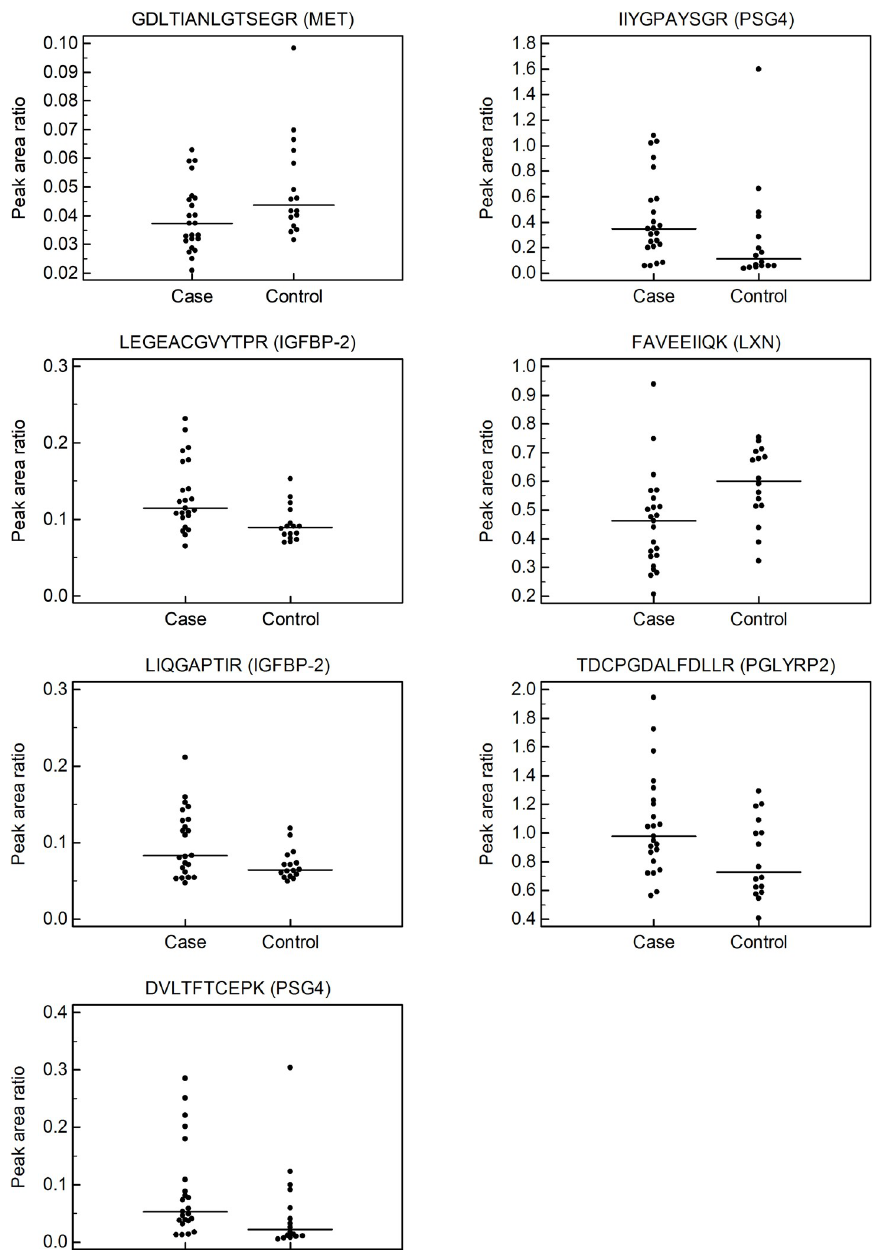
Fig 2. Interactive plots for significantly differentially expressed (3 up-regulated and 2 down-regulated) proteins in plasma of women with spontaneous preterm delivery (SPTD) at < 33 weeks of gestation after cerclage placement (case group), as determined by MRM assay. Interactive plots were generated using the normalized peak area of each MRM target peptide. The horizontal line in each figure indicates the median value. GDLTIANLGTSEGR (hepatocyte growth factor receptor [MET]); IIYGPAYSGR (pregnancy specific beta-1-glycoprotein 4 [PSG4]); LEGEACGVYTPR (insulin-like growth factor-binding protein 2 [IGFBP-2]), FAVEEIIQK (latexin [LXN]); LIQGAPTIR (IGFBP-2); TDCPGDALFDLLR (peptidoglycan recognition proteins 2 [PGLYRP2]); DVLTFTCEPK (PSG4). curves. The optimal cut-off points for cervical dilatation and the PARs of LEGEACG- VYTPR, LIQGAPTIR, DVLTFTCEPK, IIYGPAYSGR, TDCPGDALFDLLR,